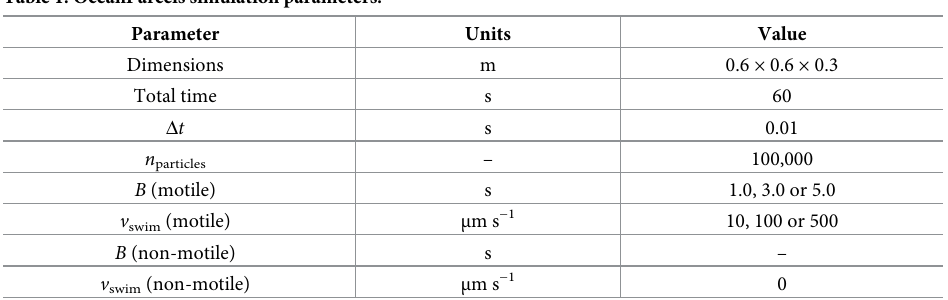
Table 1. OceanParcels simulation